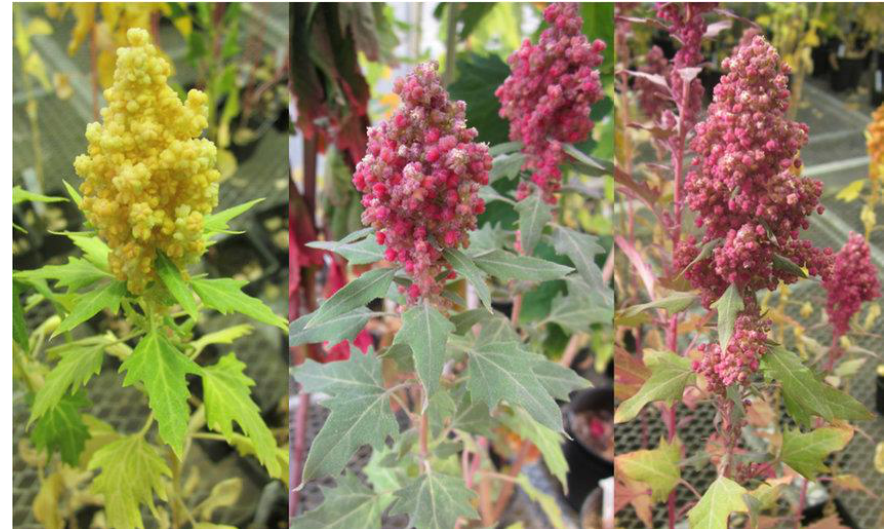
Figure 1. Quinoa plants with two different colors of grains (yellow and purple